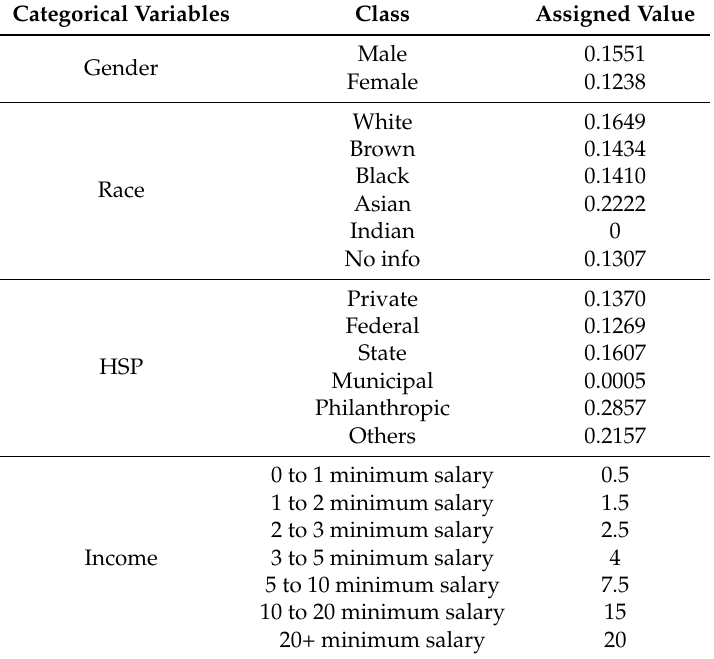
Table 5. Categorical variables with the respective classes each can assume, and the corresponding assigned value to each class. The assigned value is the dropout percentage observed in that class (the assigned values for the classes in Income variable correspond to the average of salary ranges).